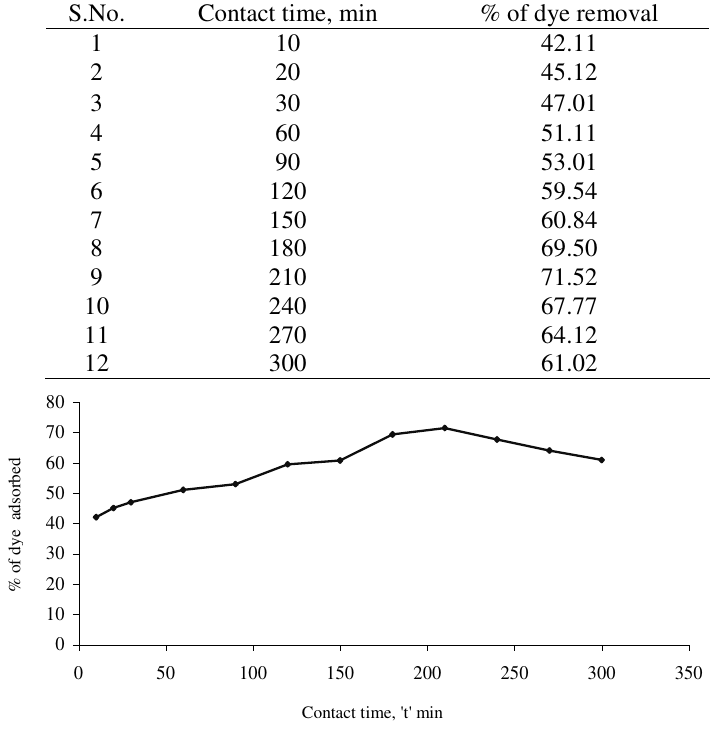
Figure 2. Effect of equilibration period Table 3. Effect of pH on adsorption ( Dye concentration: 100 mg/L; sorbent dose: 1 g/L; particle size: 400 µ ; contact time: 5 h; temperature: 300